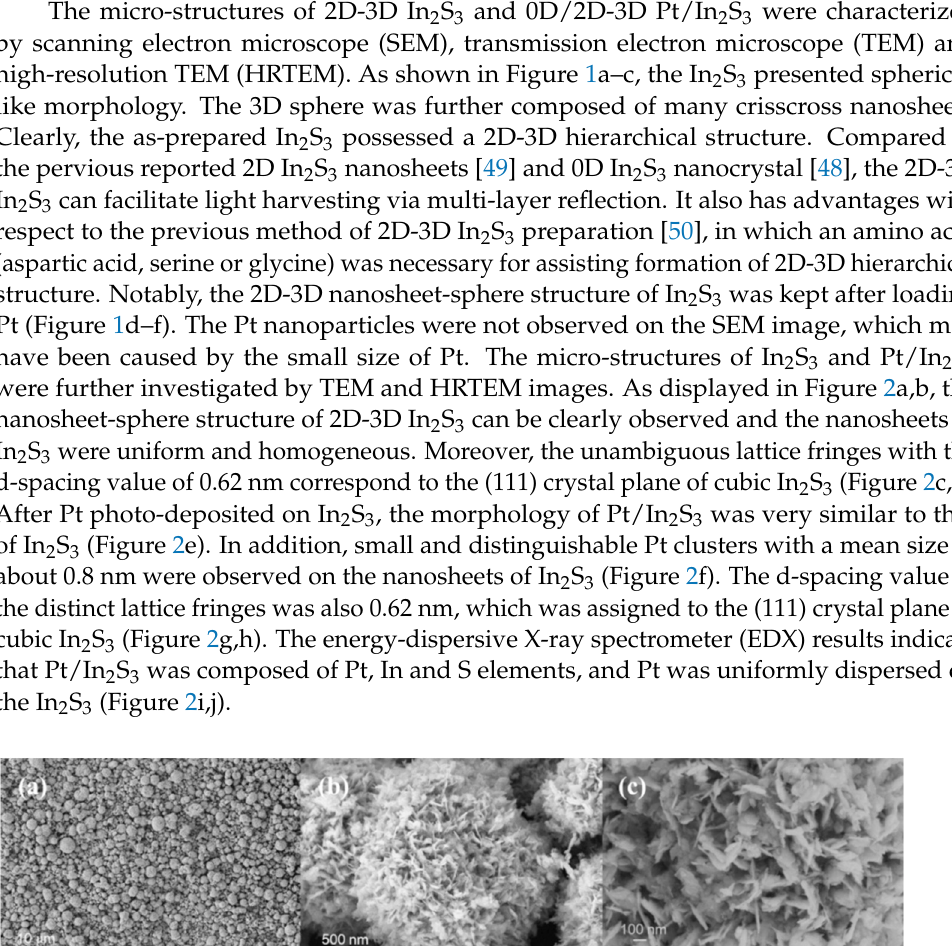
2 S 3 and ( d – f ) Pt/In 2 S 3